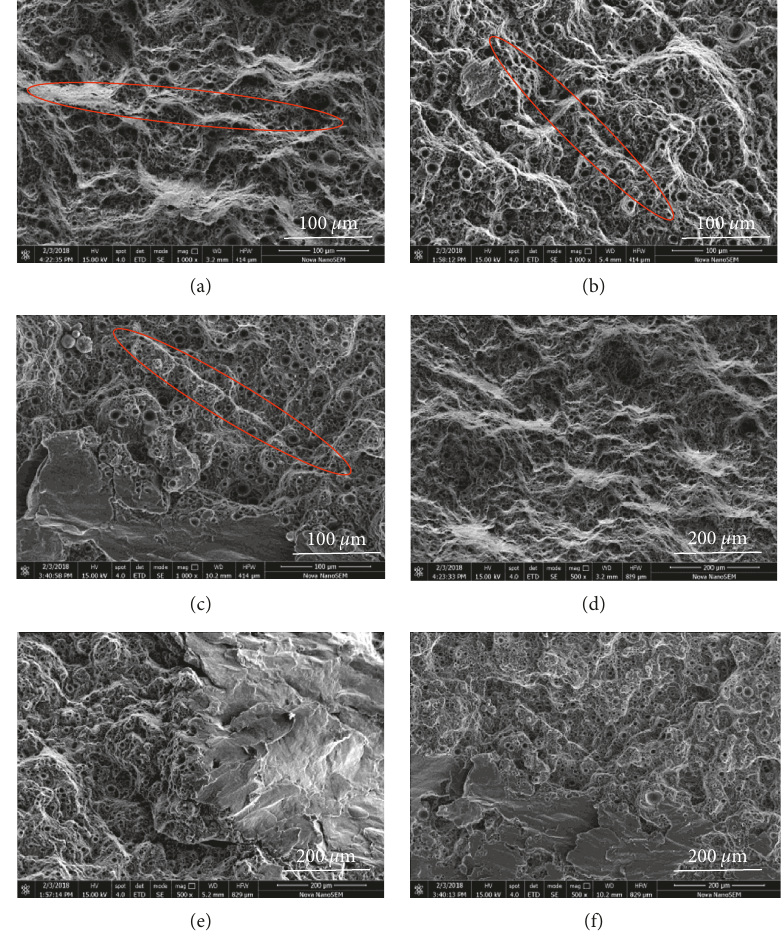
Figure 13: The typical fracture images of SLM-processed AlSi10Mg samples at (a, d) uniformity scanning, preheating temperature 80 ° C; (b, e) uniformity scanning, preheating temperature 120 ° C; and (c, f) uniformity scanning, preheating temperature 160 °